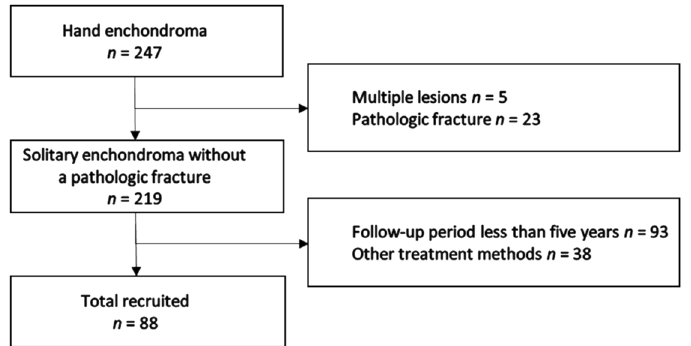
Figure 4. STROBE diagram demonstrates the patient selection